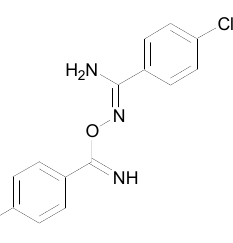
Figure 7. Dimeric product obtained from 4-chlorobenzamidoxime.